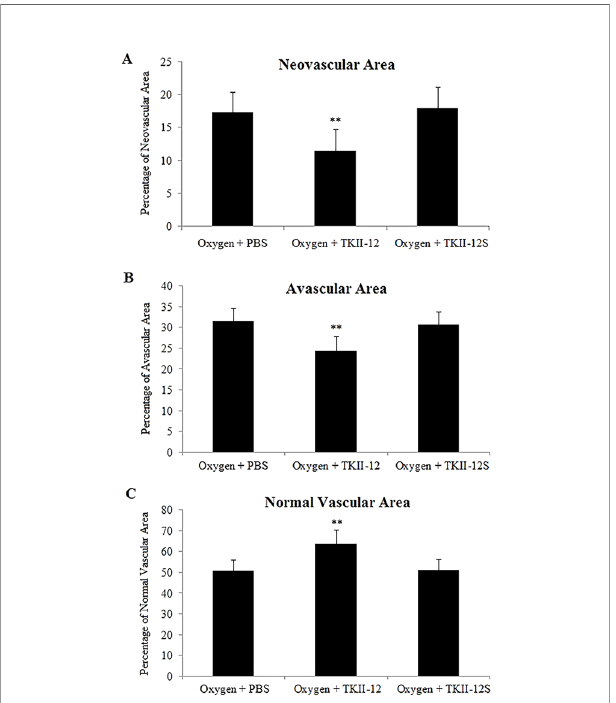
FIGURE 7 | Quantitative analysis of the effects of TKII-12 on oxygen-induced retinopathy in a mouse model. Quanti fi cation of neovascularization (A) , avascularization (B) , and normal vascularization (C) of each group were performed at P17. ** p < 0.01 versus the oxygen plus phosphate-buffered saline (PBS)